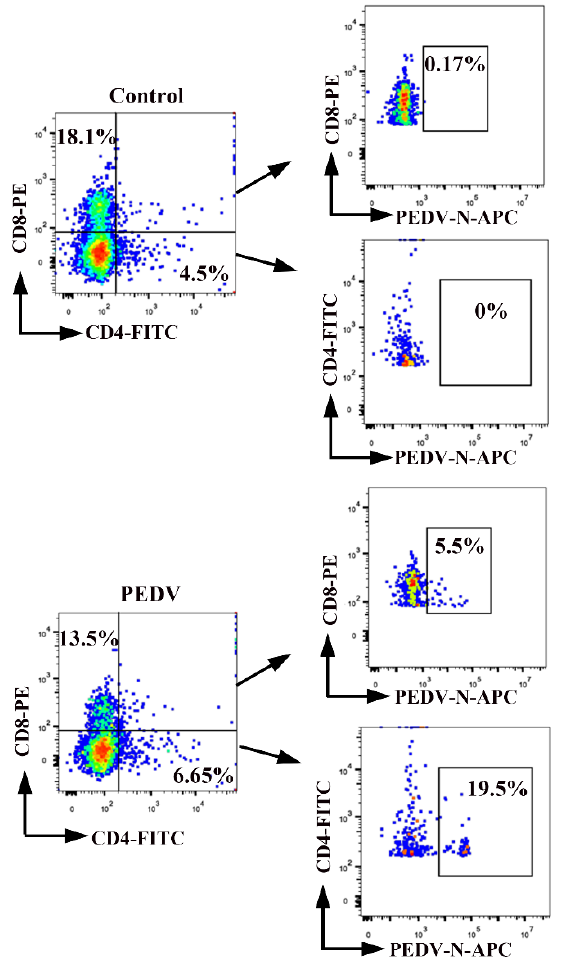
Figure 4. CD4 + and CD8 + subsets of T cells become infected with PEDV. PBMCs were inoculated at an MOI of 0.1 with PEDV. Percentages of PEDV-positive CD4 + T cells and PEDV positive CD8 + T cells were detected by FACS. The percentage of positive cells in each quadrant is shown. FACS: Fluorescence Activated Cell Sorte.